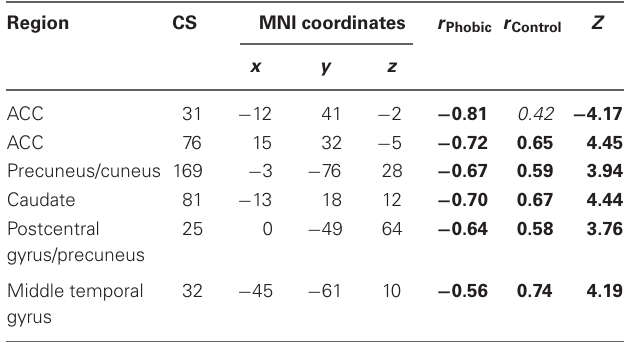
Table 1 | Correlations between gaze duration spider – bird and BOLD contrast spider – bird ; whole brain analysis.